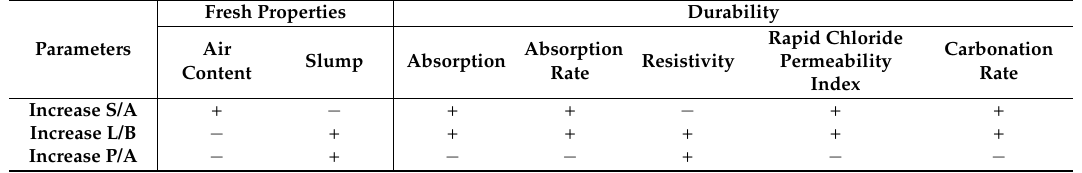
Table 3. Comparison of fresh properties and durability for three mix design